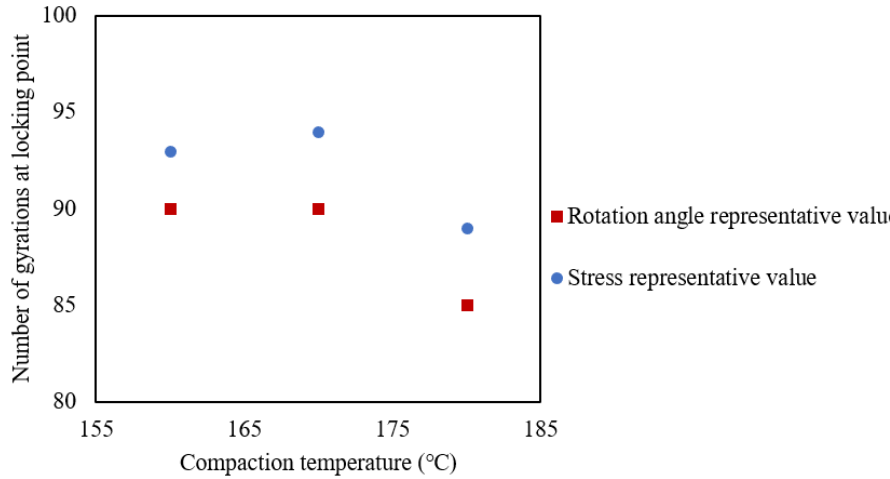
Figure 13. Locking point comparison diagram.